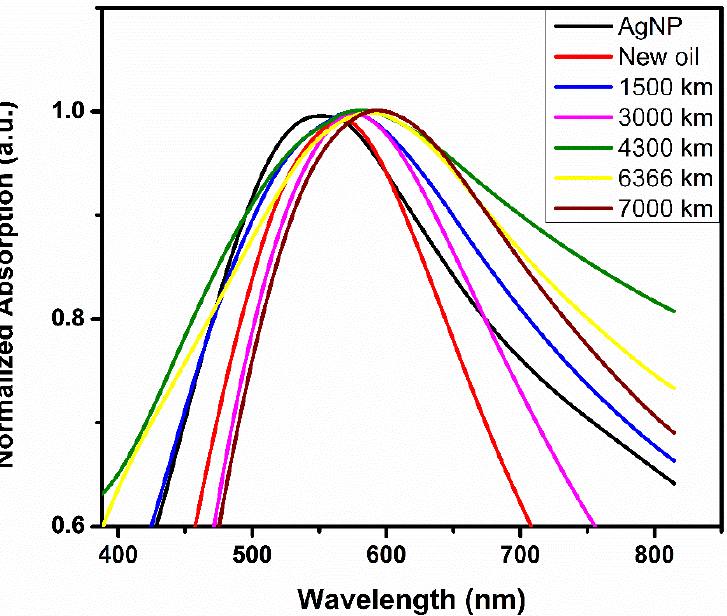
Figure 7. ( a ) EDS spectrum of the covered area on the polystyrene surface. It confirms the presence of AgNP. SEM micro- graphs of the AgNP deposited on polystyrene cell before ( b ) and after ( c ) measuring all the oil samples, no apparent variation in size or shape caused by interaction with degraded oil can be observed.